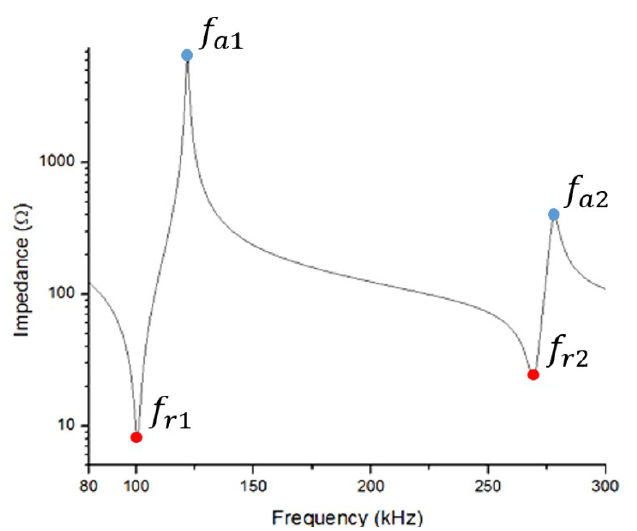
Figure 1. Schematics in resonant and anti-resonant frequencies obtained by impedance analyzer.